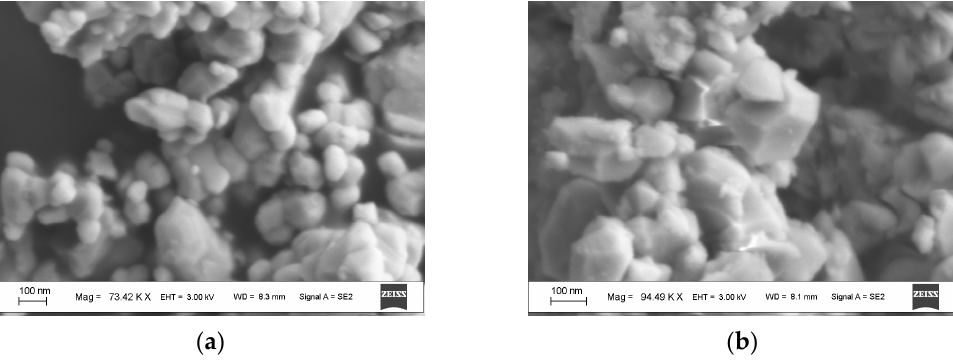
Figure 46. Scanning electron microscopy images of nickel ferrite nanoparticles: NA ( a ) and NB ( b ). Adapted from Ref. [79] with permission from Elsevier: Materials Chemistry and Physics, Vol. 202, Ushakov M.V., Senthilkumar B., Kalai Selvan R., Felner I., Oshtrakh M.I., “Mössbauer spectroscopy of NiFe 2 O 4 nanoparticles: the effect of Ni 2+ in the Fe 3+ local microenvironment in both tetrahedral and octahedral sites”, 159–168, ©2017.